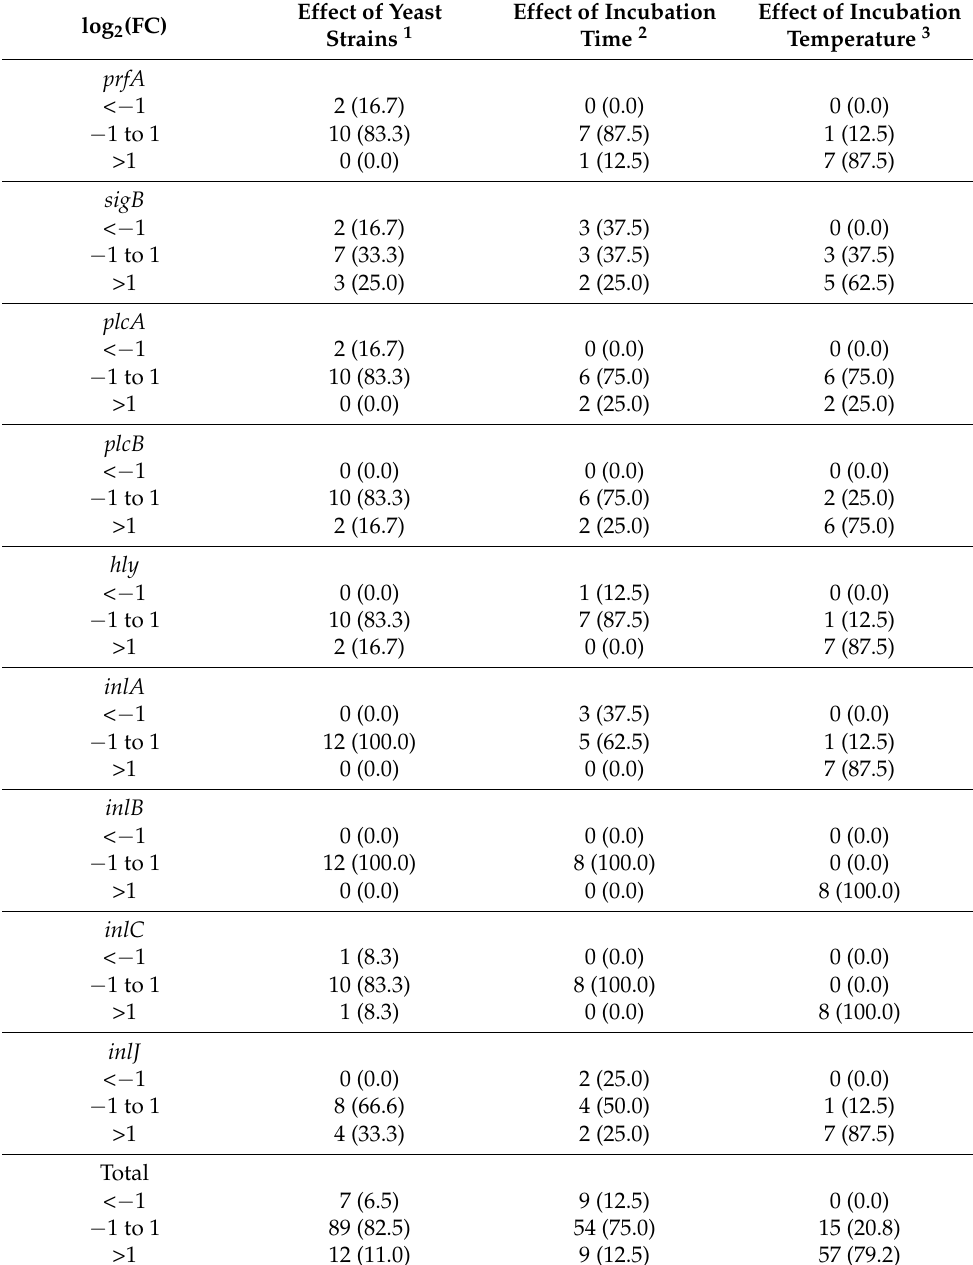
Table 2. Number of samples in which the relative transcription of the genes under study was below, above or within the threshold set. Percentage is given in